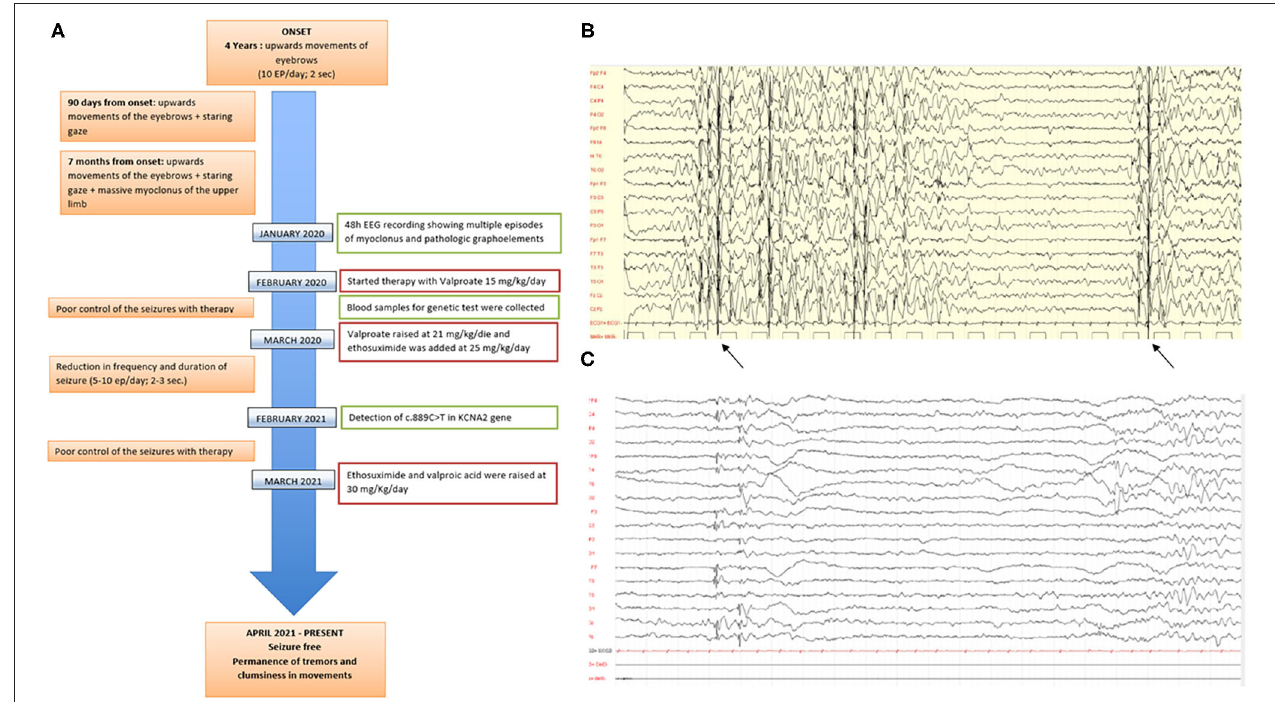
FIGURE 1 | (A) Timeline of clinical features, instrumental characteristics, and therapy approaches in the proband since the toddler started showing epilepsy. (B,C) Electroencephalogram (EEG) performed when the child was 4 years old. The trace is characterized by poorly organized brain electrical activity, slow anomalies with interictal paroxysmal abnormalities on bilateral parieto-occipital sites, and abundant epileptiform anomalies with diffuse